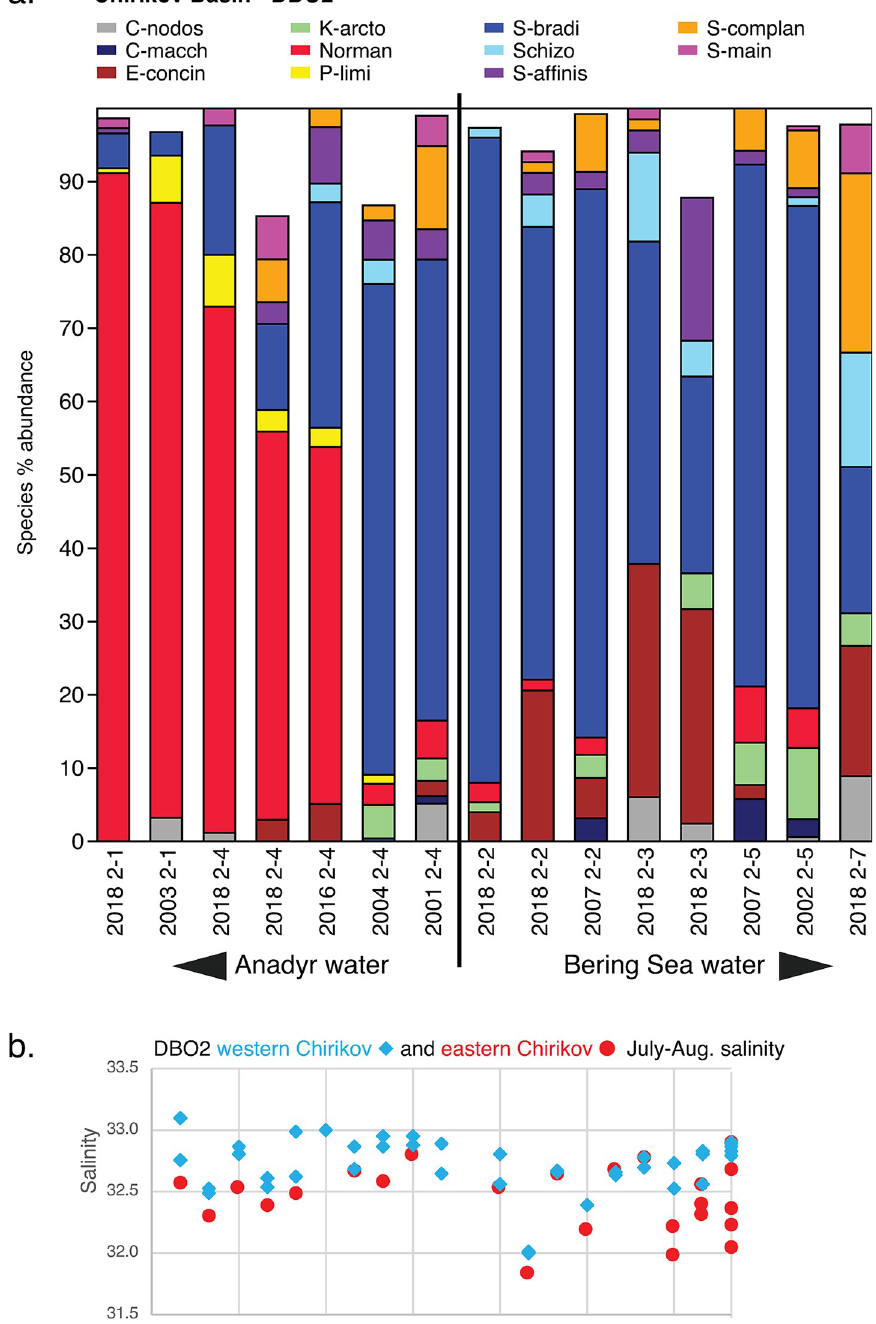
PLOS ONE | https://doi.org/10.1371/journal.pone.0251164 May 13,